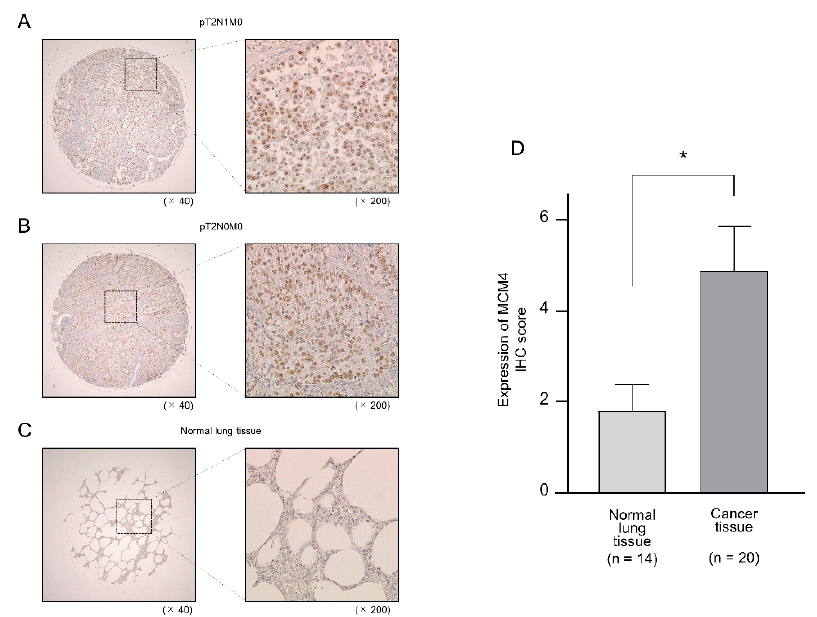
Figure 9. Aberrant expression of MCM4 in LUAD clinical specimens. Patient characteristics showed in Table S3. ( A – C ) Expression of MCM4 was investigated by immunohistochemistry staining of LUAD specimens and normal lung tissues. Overexpression of MCM4 was detected in nuclei of cancer lesions, whereas negative or low expression of MCM4 was observed in normal lung tissue ( A ; patient no.16, B ; patient no.19, C ; patient no.31). ( D ) Comparison of the scoring of MCM4 expression in clinical lung specimens. Expression scores of MCM4 in LUAD tissues were significantly higher than those in normal lung tissue (* p = 0.0414).